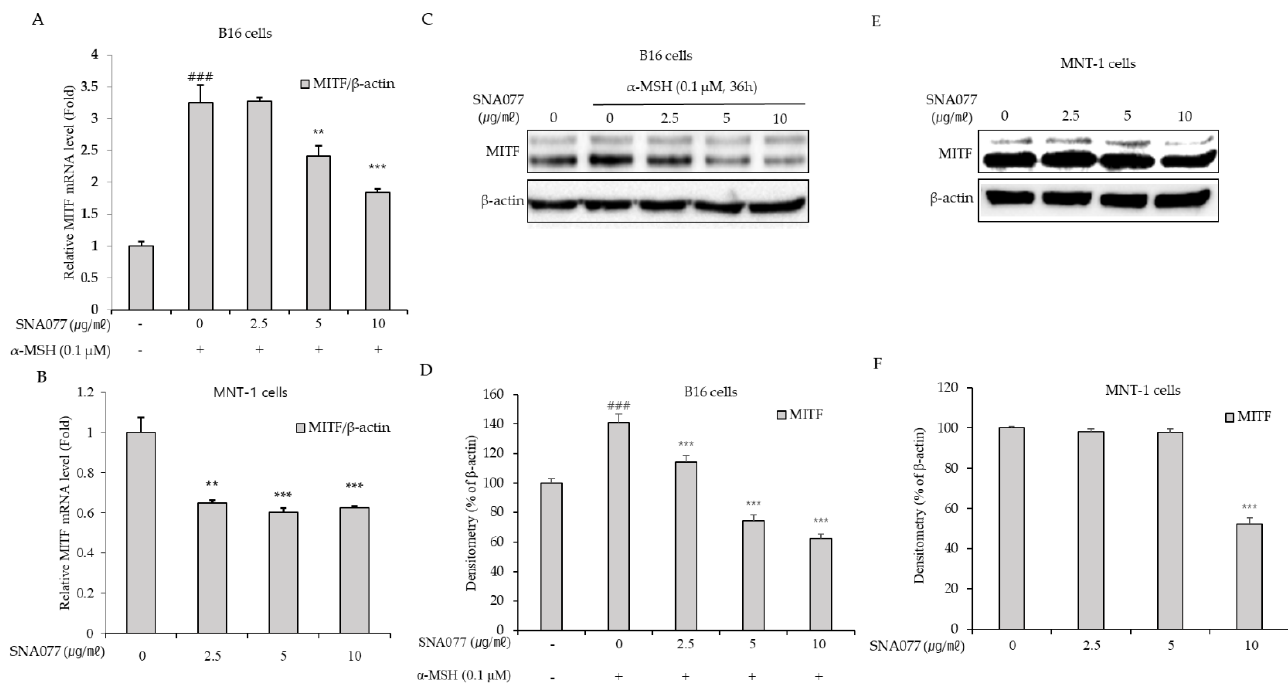
Figure 4. Inhibitory effect of SNA077 on the gene expression of MITF in melanocytes. ( A , B ) The mRNA level of MITF was determined by real-time qPCR in B16 cells ( A ) and MNT-1 cells ( B ). Cells were treated with SNA077 for 24 h. The mRNA level of MITF was normalized to that of β -actin. ( C , E ) The protein level of MITF was determined by Western blot analysis in B16 cells ( C ) and MNT-1 cells ( E ). Cells were treated with SNA077 for 36 h or 48 h. Equal amounts of proteins were resolved by 10% SDS-PAGE and detected using specific antibodies; β -actin was detected as a loading control. ( D , F ) Protein bands were densitometrically quantified and analyzed using ImageJ software. Results for B16 cells ( D ) and MNT-1 cells ( F ) are presented as means ± SD, expressed as a percentage relative to controls (** p < 0.01, *** p < 0.001 vs. control group; ### p < 0.001 vs. the α -MSH-untreated control group).